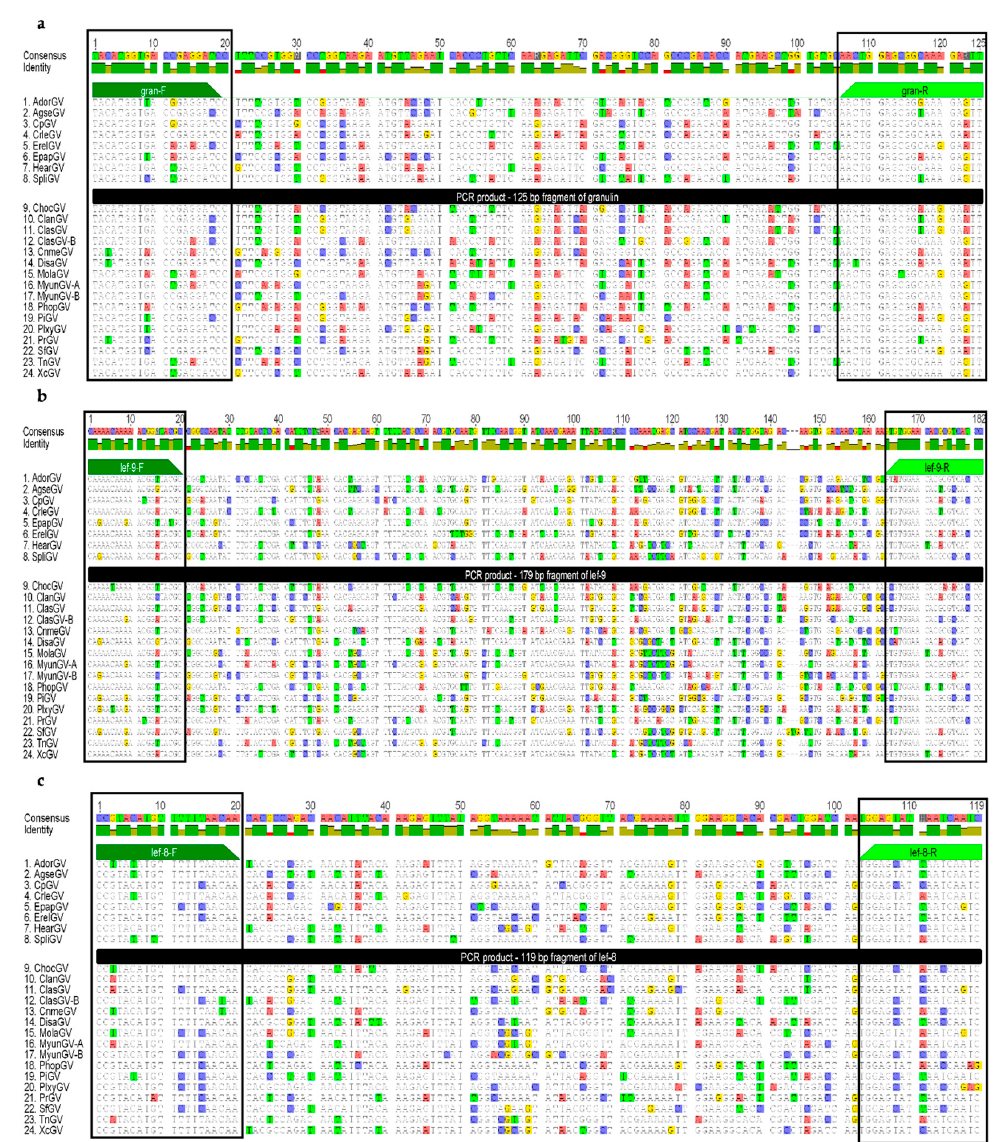
Figure 3. The alignment of nucleotide sequences of ( a ) granulin (125 bp), ( b ) lef-9 (179 bp), and ( c ) lef-8 (119 bp) fragments from betabaculovirus complete genomic sequences available in GenBank. 1–8 are representative groups in this study, and 9–24 are all the remaining granuloviruses. Dark and light green annotations show primers: ( a ) forward gran-F and reverse gran-R, ( b ) forward lef-9-F and reverse lef-9-R; and ( c ) forward lef-8-F and reverse lef-8-R. The histogram on the top shows the identity in every column of the